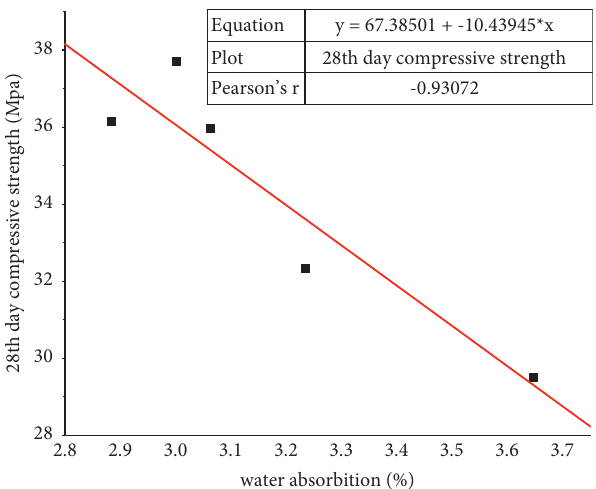
Figure 7: Compressive strength and water absorption